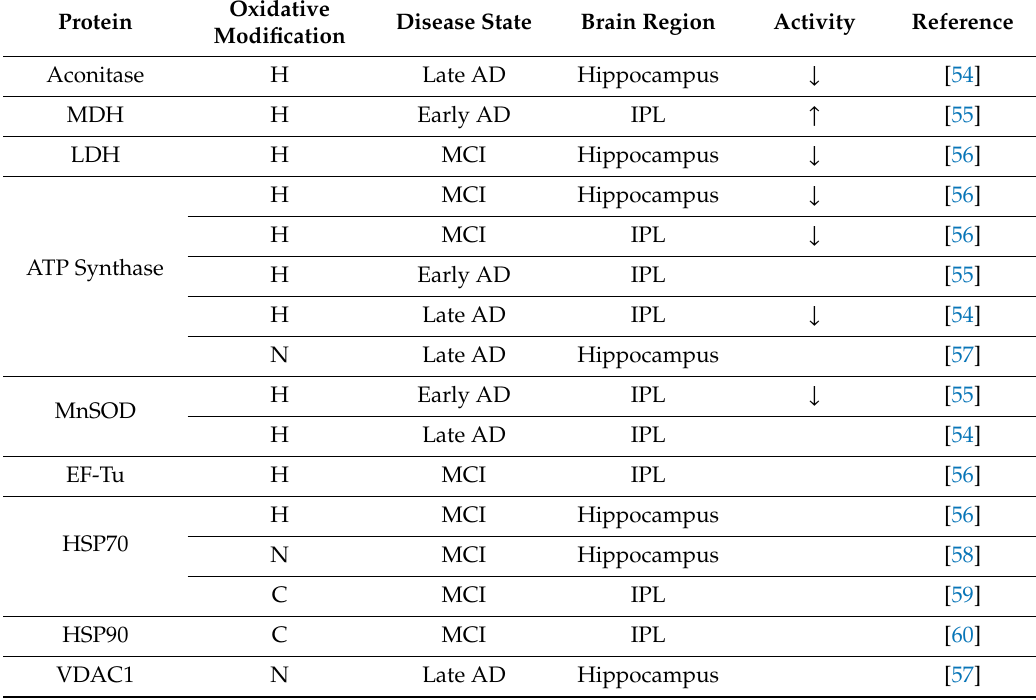
Table 1. Summary of oxidatively modified mitochondrial proteins identified by redox proteomics and enzymatic activity in mild cognitive impairment (MCI) and Alzheimer disease